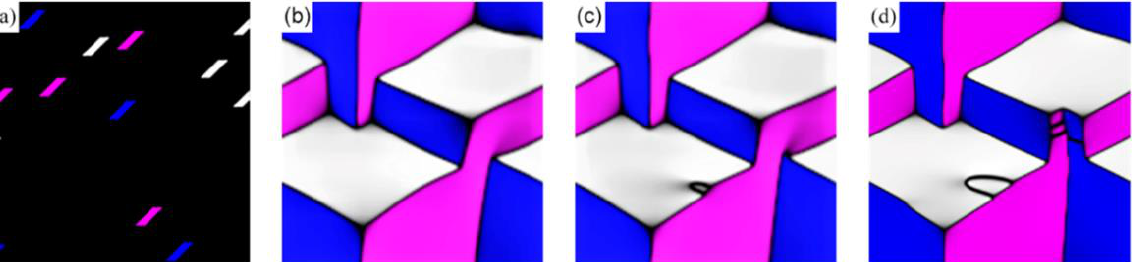
Figure 5. Variant morphology evolution for different magnetic field intensities. ( a ) Random distribution of nucleation sites, ( b ) the final steady state for 0 T magnetic field, ( c ) the final steady state for 10 T magnetic field, and ( d ) the final steady state for 20 T magnetic field.